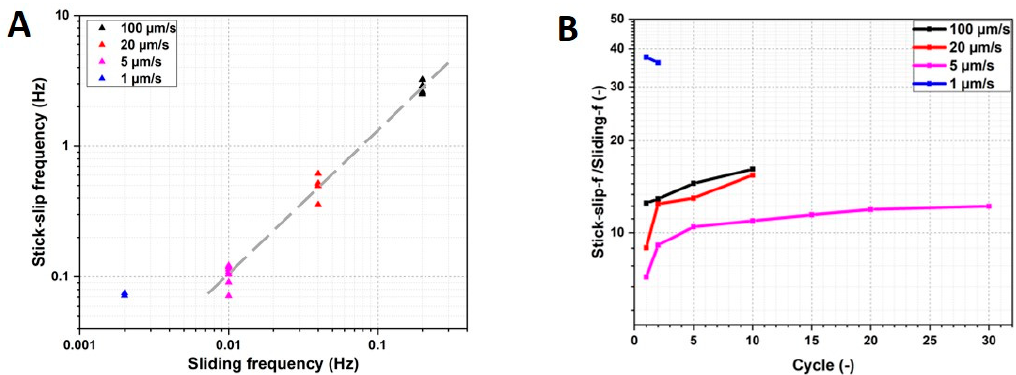
Figure 6. ( A ) Relation of stick-slip frequency and sliding frequency in the first trace. ( B ) Relation of stick-slip frequency/sliding frequency with cycles.